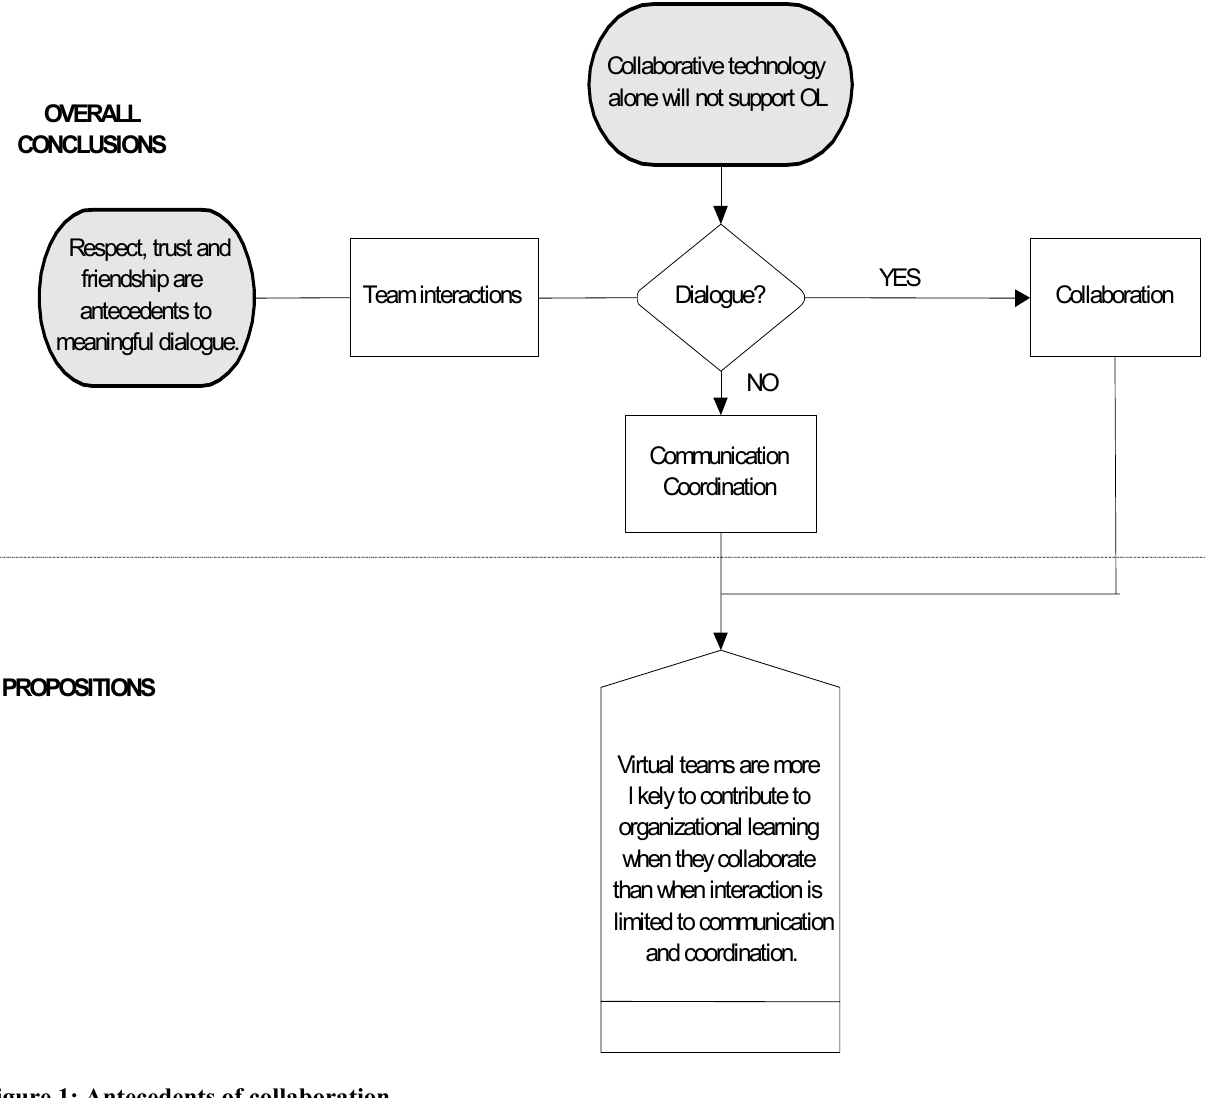
Figure 1: Antecedents of